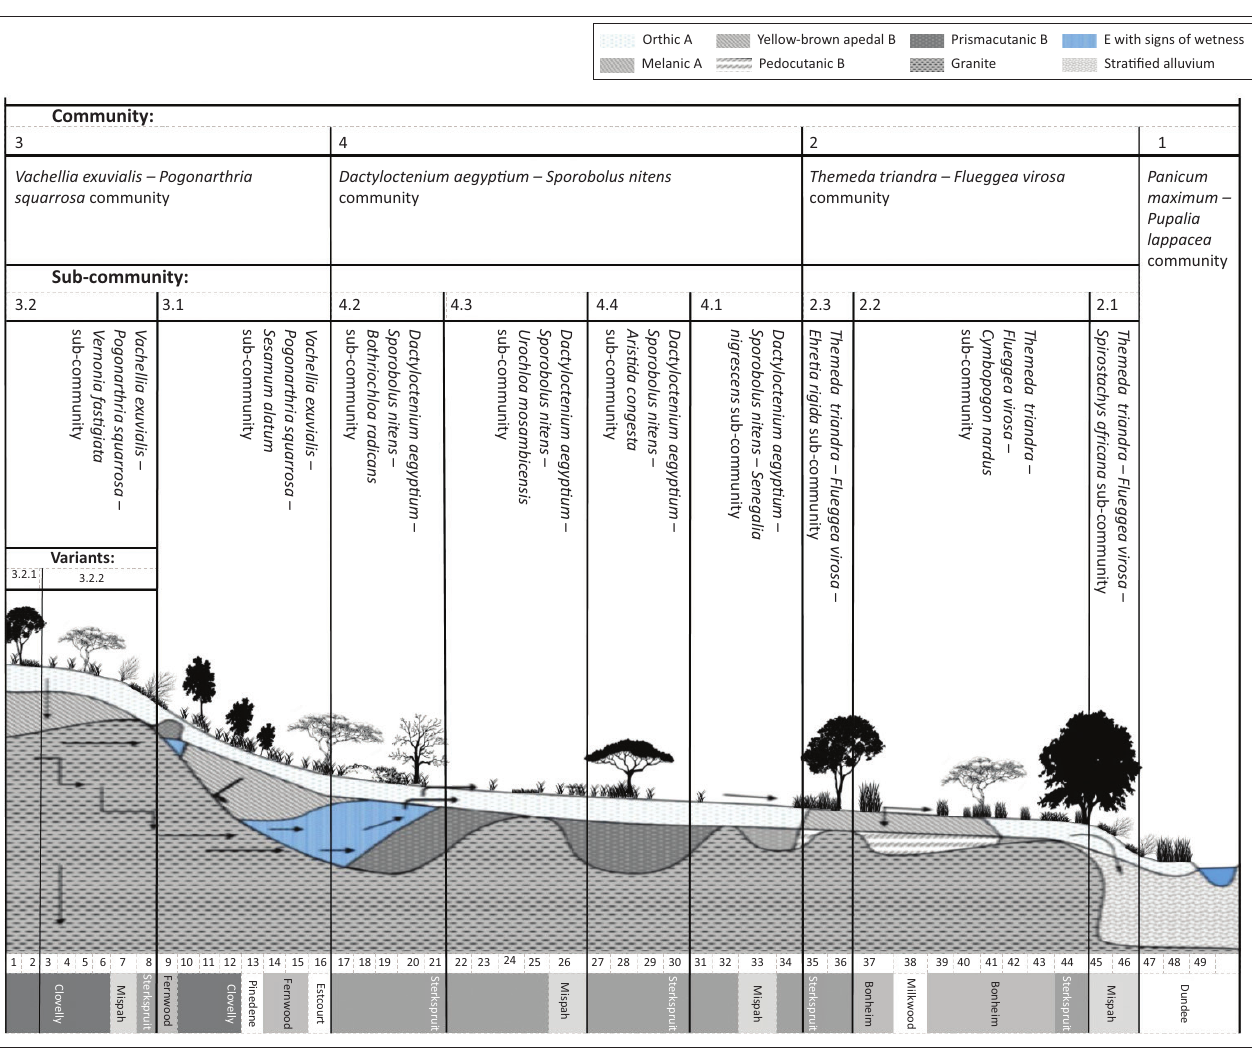
FIGURE 2: Plant community, sub-community and variant distribution aligned with the relevés and soil forms (at the bottom) on which they occur along a hillslope gradient. Arrows indicate the movement of water through the soil sequence (see Bouwer, Le Roux & Van Tol 2020 for a detailed